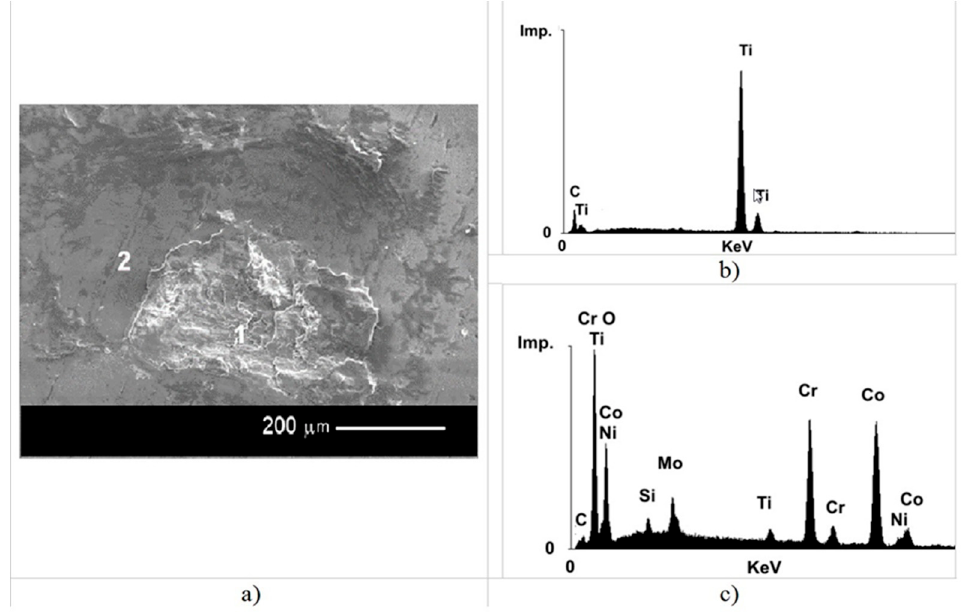
Figure 6. Area of friction tracks obtained with the load of 15 MPa and for the time of 120 min for sample S1. ( a ) Microscopic image with marked areas of EDS analyses; ( b ) EDS analysis in point 2; ( c ) EDS analysis in point 1.